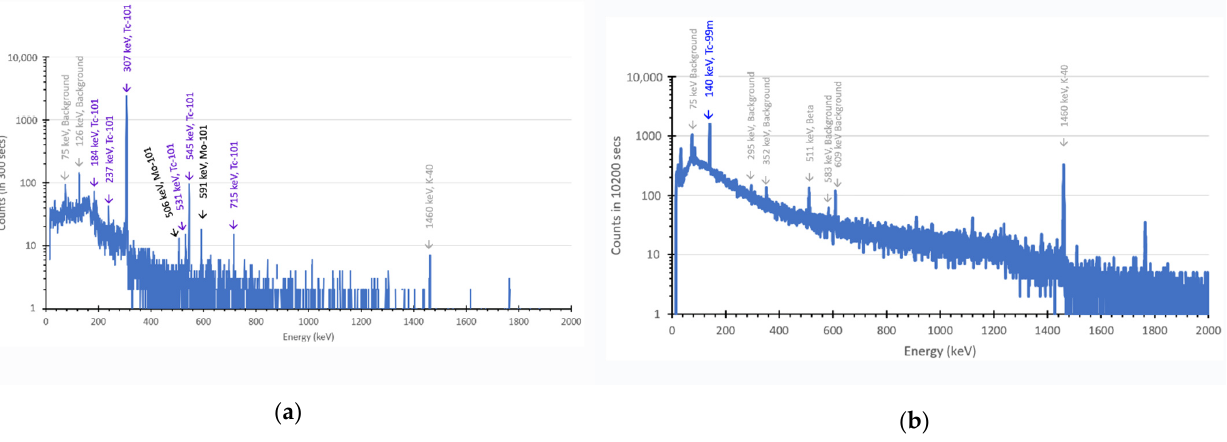
Figure 5. ( a ) Extraction immediately following irradiation yielding 101 Tc (purple) with residual 101 Mo (black). ( b ) Extraction after a day of the same irradiated AHM solution yielding only 99m Tc (blue). Peaks arising from background contributions are shown in